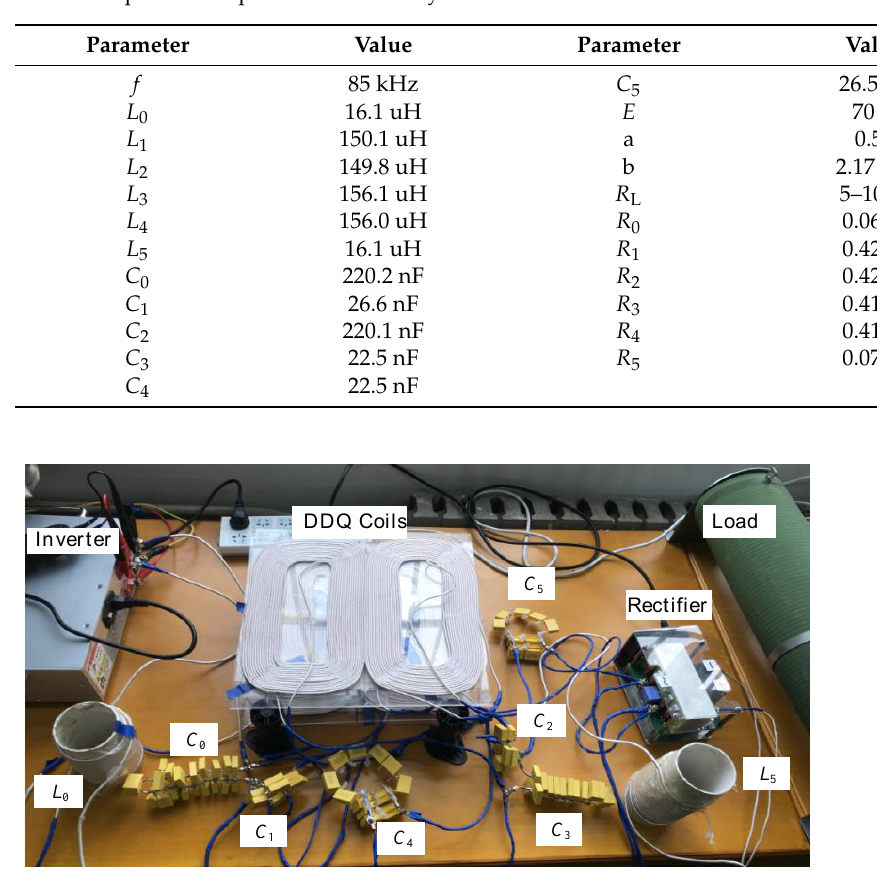
Figure 8. Current output of the hybrid IPT system with the PSO parameters.